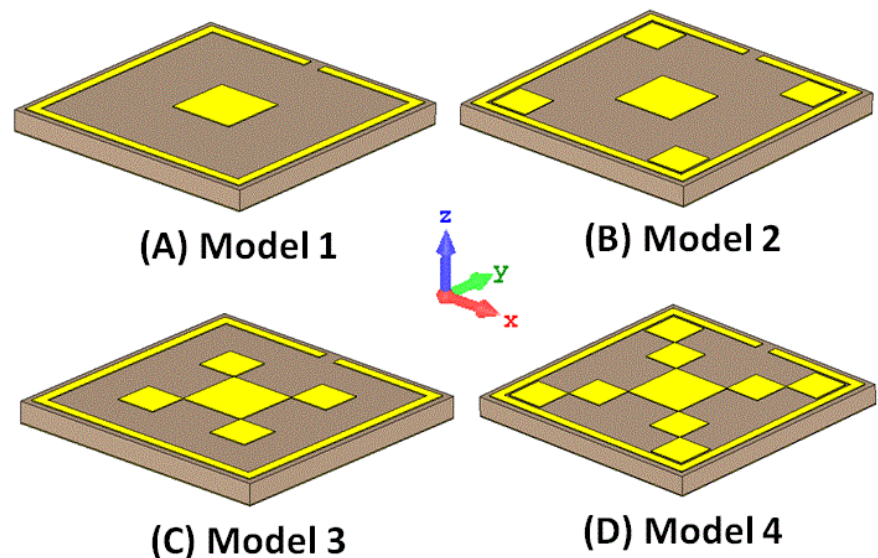
Figure 2. Steps involved in the design of the proposed absorber.